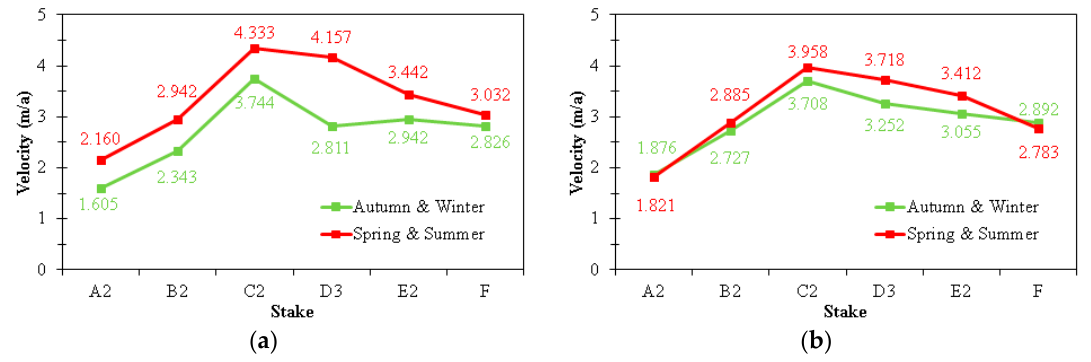
Figure 5. ( a ) The comparison of velocities (m/a) in different seasons in 2016. ( b ) The comparison of mean velocities (m/a) in different seasons over 2009–2016. The different colors denote different seasons.